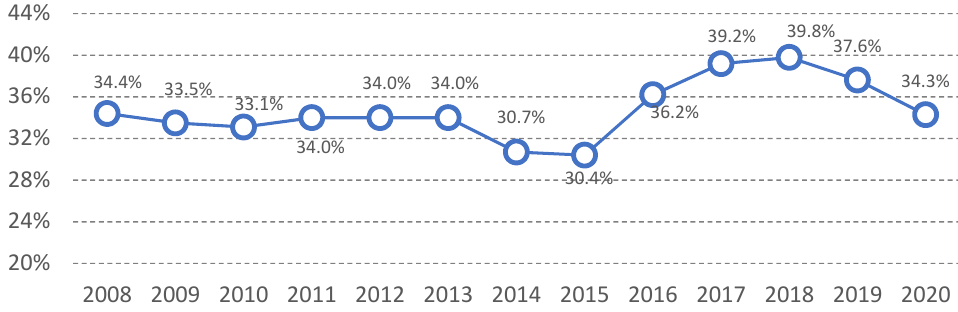
Figure 2. MTPL share in non-life premiums between 2007 and 2020 (UKNF 2021).